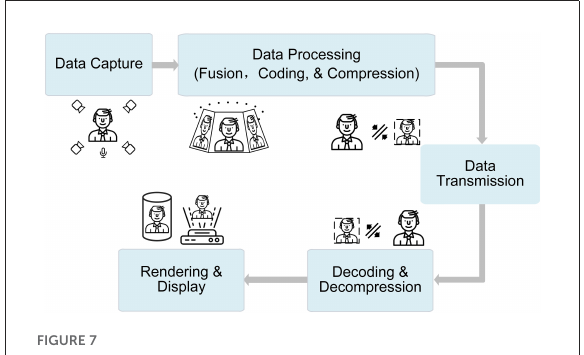
FIGURE7 Implementation procedure of holographic communication.